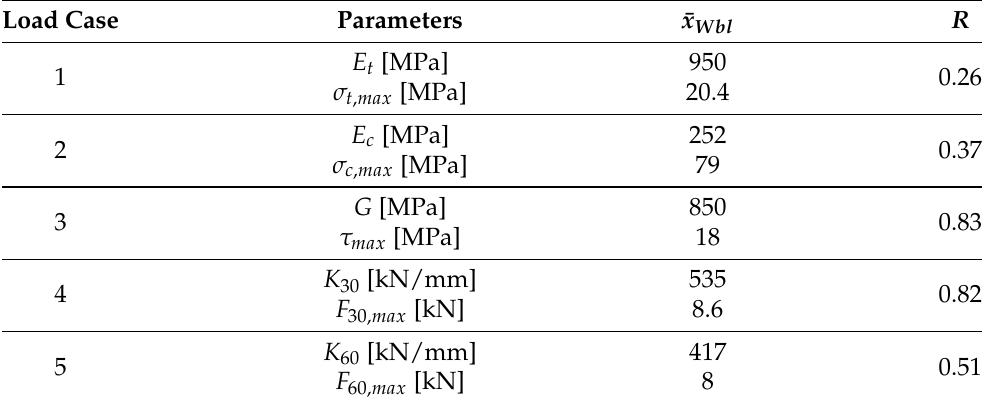
Table 5. Summaryof results for LCs 1–5. ¯ x Wbl corresponds to the Weibull mean value of the parameters and R is the correlation